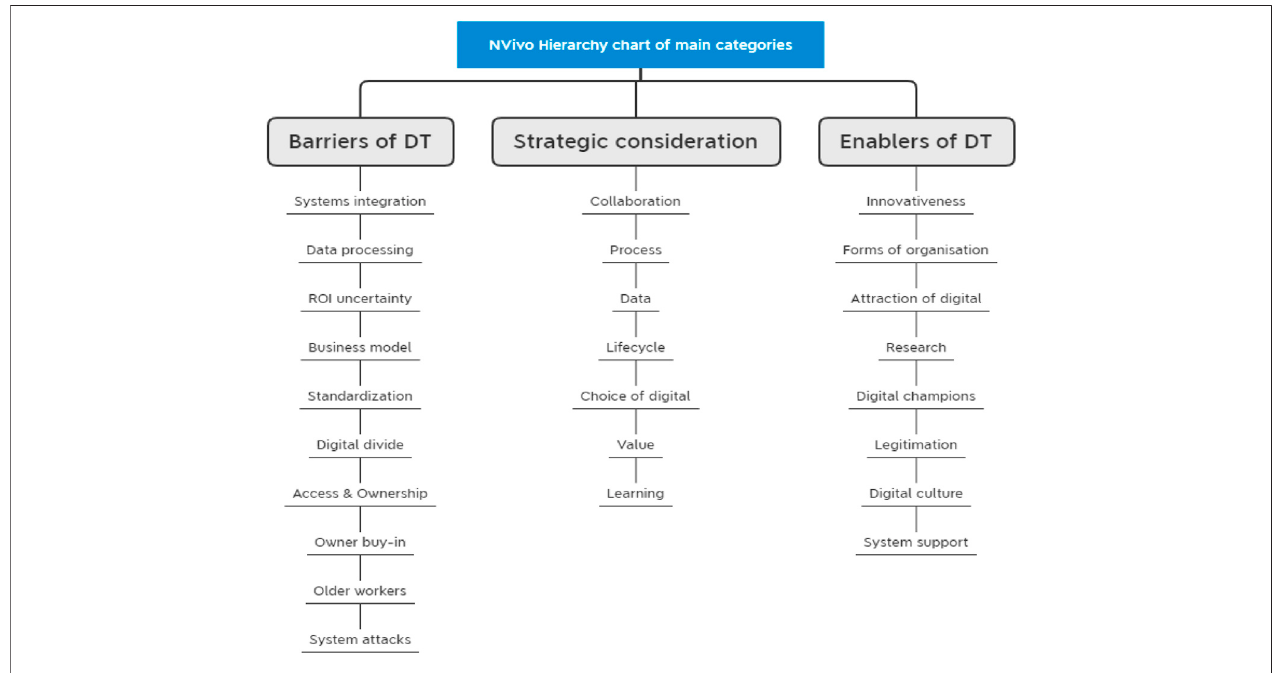
FIGURE 3 | NVivo hierarchy chart of the main categories (redesigned by authors).